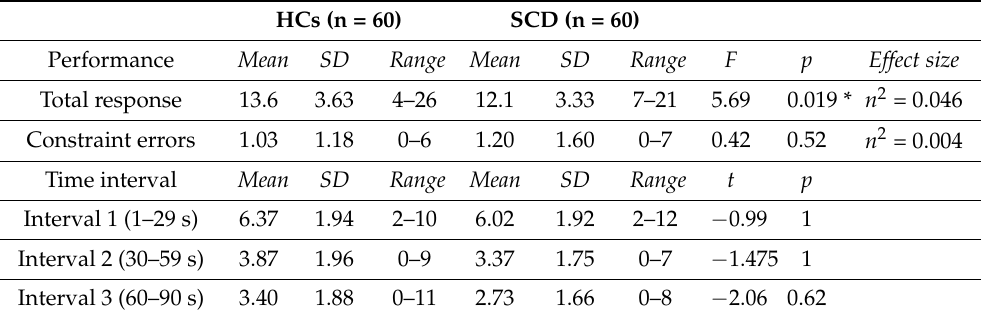
Table 4. The results on the Constraint fluency task according to Group, Performance and Time